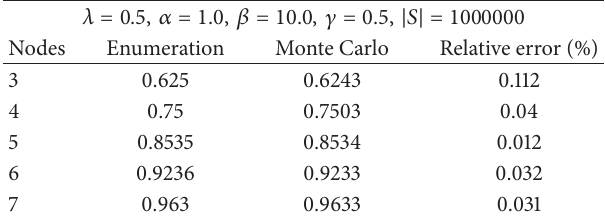
Table 3: The comparison of enumeration result and simulation